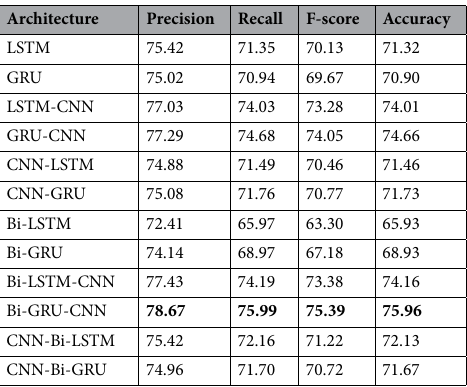
Table 8. Performance of models trained on the Hybrid dataset and tested using the BRAD test set. Significant values are in given in bold.